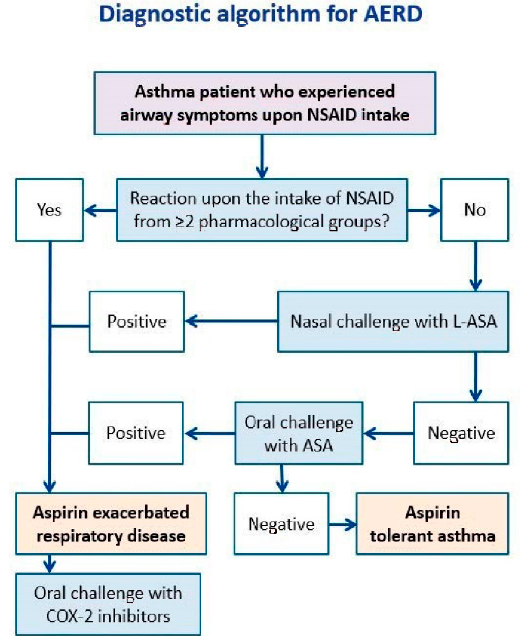
Figure 4. Diagnostic algorithm for aspirin-exacerbated respiratory disease. ASA: acetylsalicylic acid; L-ASA: lysine-acetylsalicylic acid; NSAID: non-steroidal anti-inflammatory drug.